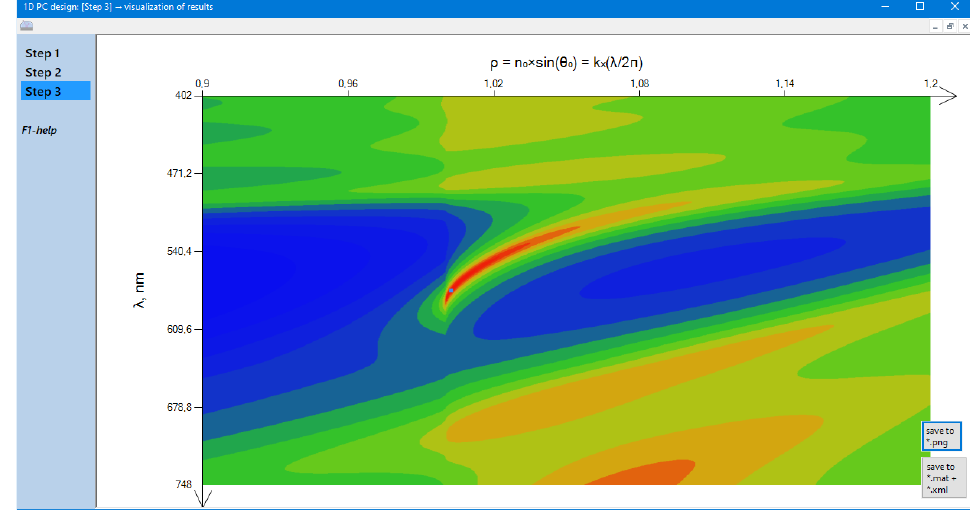
Figure 7. Optical dispersion in Step 3 program’s